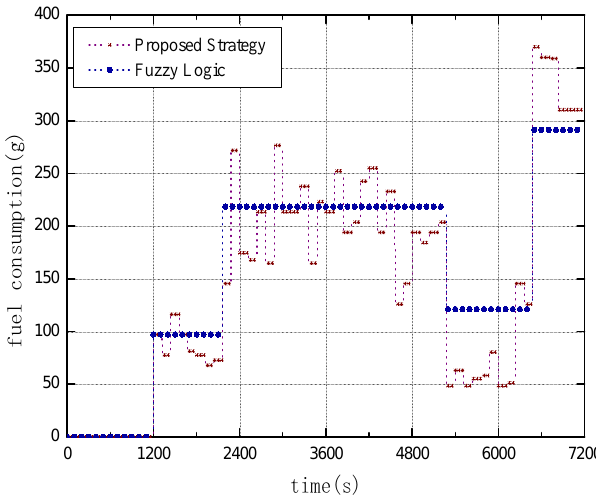
Figure 7. Fuel consumption comparison of the two compared strategies.